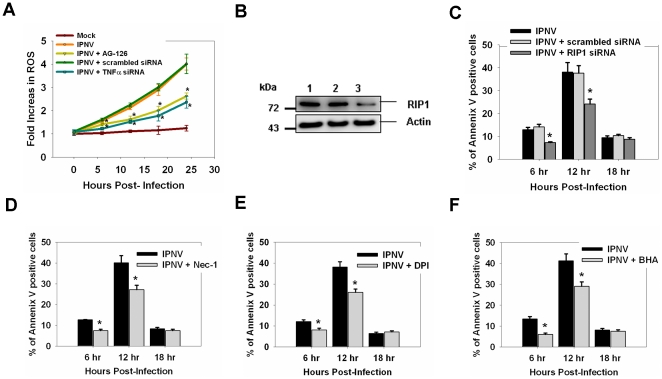
Inhibition of TNFR1 necrotic signaling complex formation inhibits apoptosis and ROS formation in IPNV-infected cells.(A) Detection of ROS production in TNFα-specific siRNA or AG-126 pre-treated cells after IPNV infection at 0, 6, 12, 18 or 24 h p.i. Fluorescence assays were performed in triplicate. Determination of the percentage of PI-positive cells after IPNV infection. (B) Detection of RIP1 in untreated or TNFα-specific siRNA-treated ZF4 cells by western blotting. Lane 1: untreated IPNV-infected ZF4 cells; lane 2: IPNV-infected ZF4 cells treated with scrambled siRNA; lane 3: IPNV-infected ZF4 cells treated with RIP1-specific siRNA. The expression of actin was used as an internal control. Detection of annexin V-positive cells following infection with IPNV. ZF4 cells were pre-treated with RIP1-specific siRNA (C), Nec-1 (D), DPI (E) or BHA (F), infected with IPNV (MOI = 1), and incubated for 0, 6, 12, 18 and 24 h. Three individual experiments were performed for each sample. Data shown are the mean ± SD. Student's t tests indicate significant differences compared to IPNV infection only: *, p<0.05.